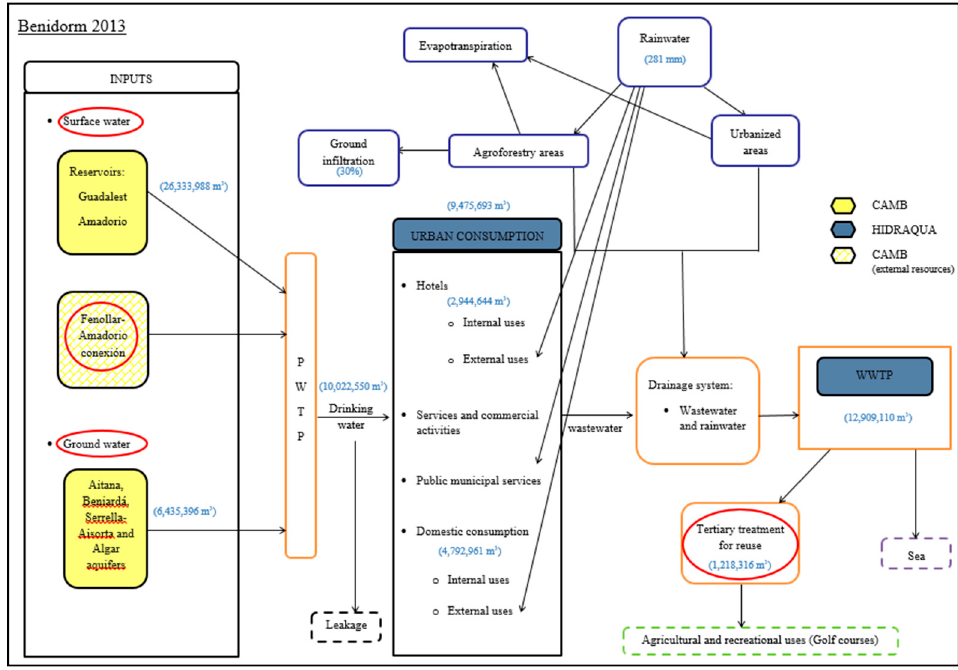
Figure 4. Flow diagram of the city of Benidorm in 2013. Compiled by the author.